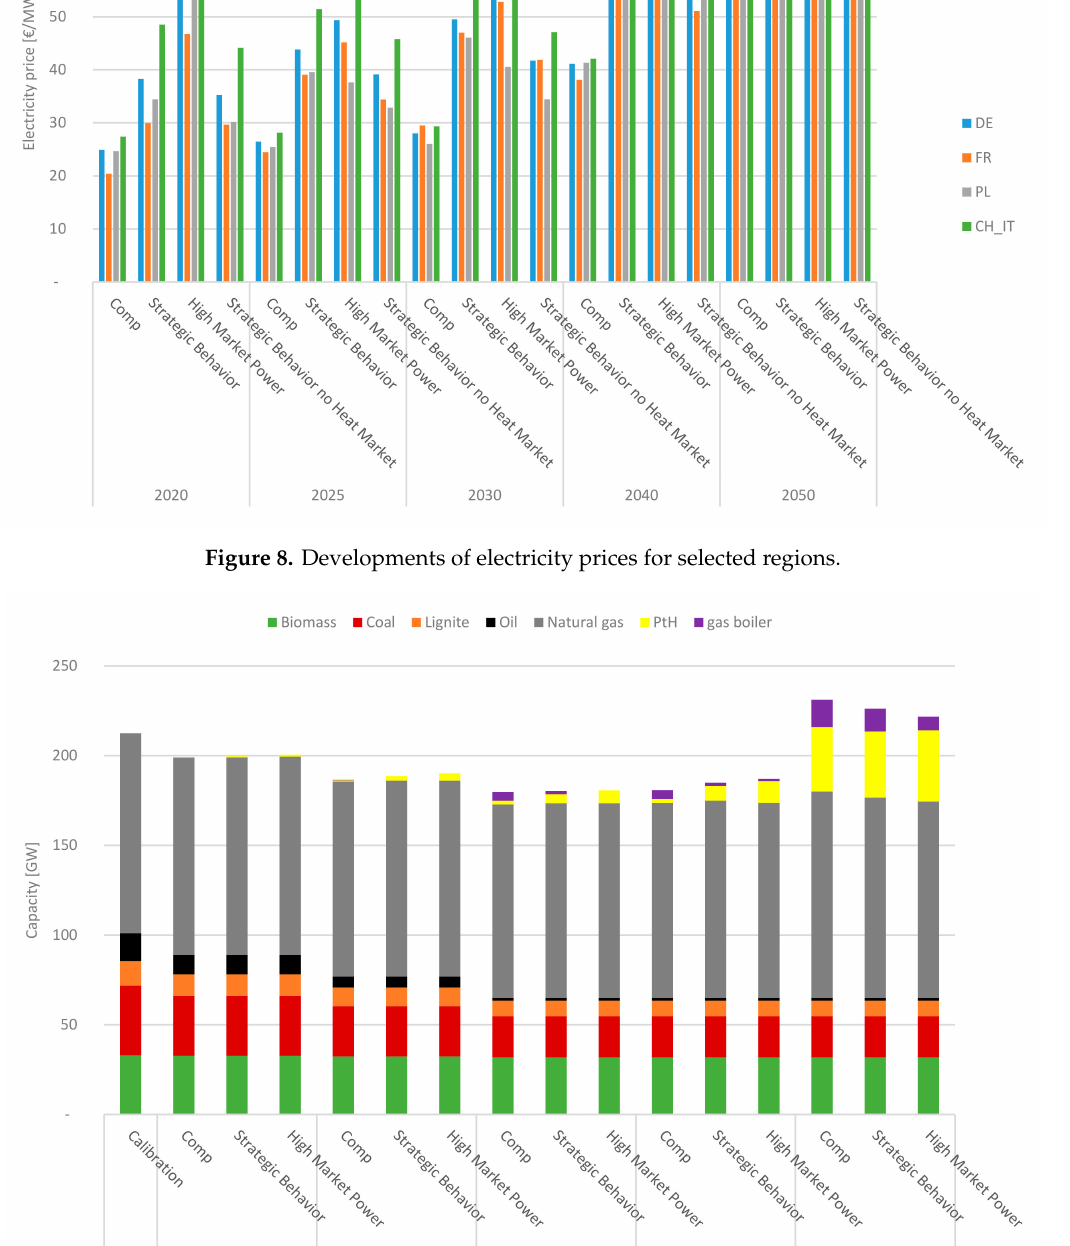
Figure 9. Developments of the installed heating capacity of CHP units and other heat sources by